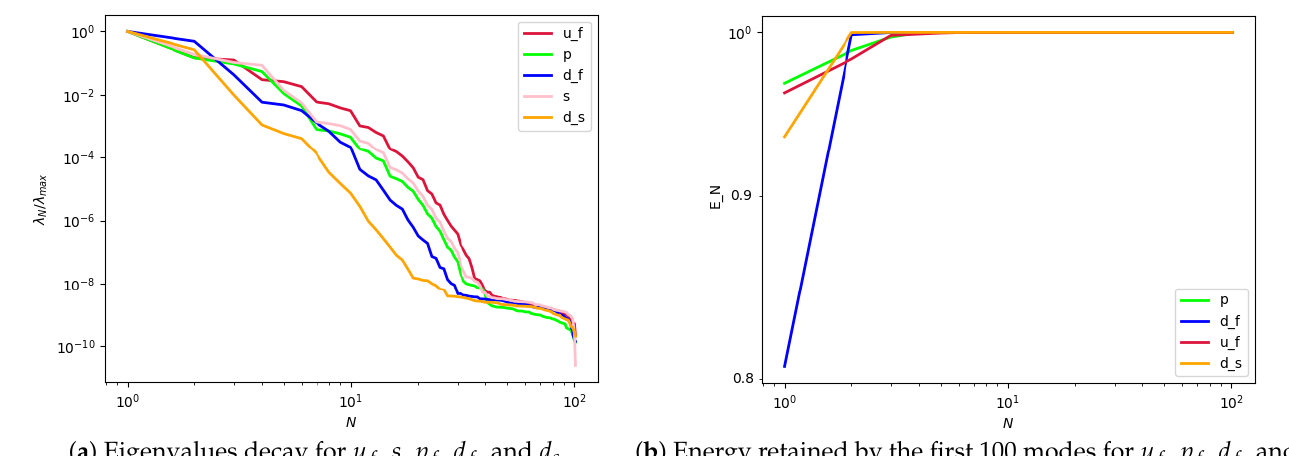
Figure 3. The outcomes of the monolithic POD: eigenvalue decay ( a ) and retained energy ( b ) for the first 100 modes.